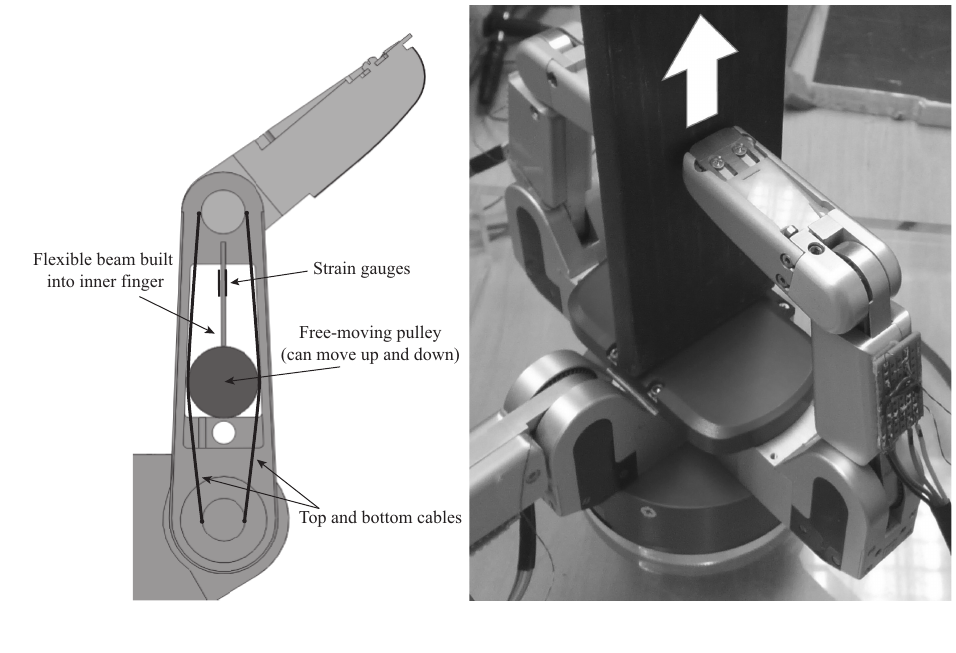
Figure 14. ( a ) A cutaway diagram of the finger reveals the internal strain gauges on the BarrettHand; ( b ) The experimental setup with the